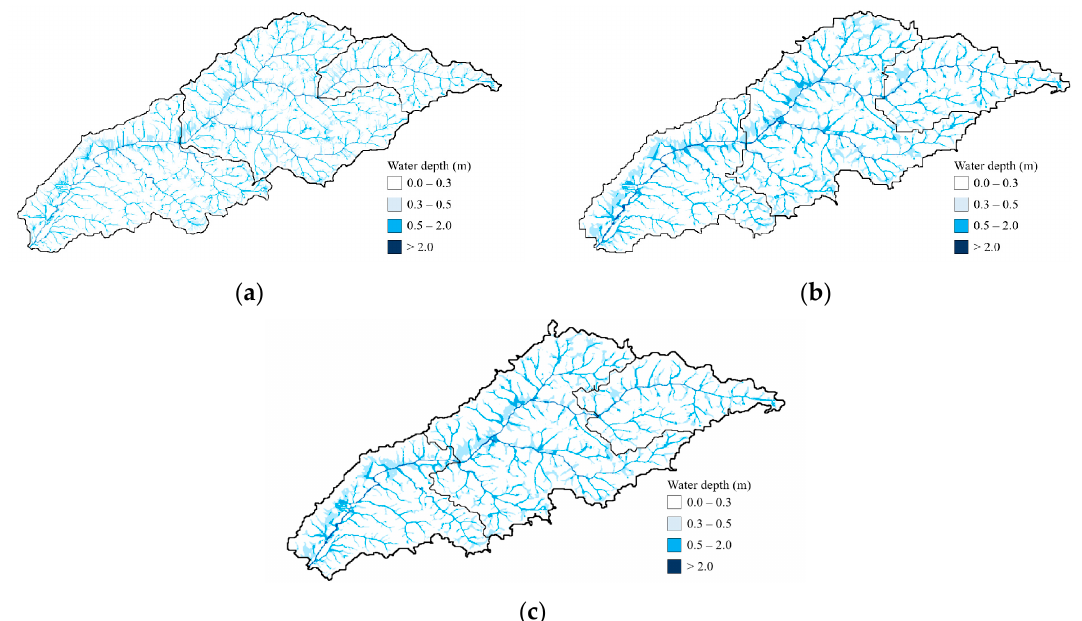
Figure 7. Comparison of water-depth distribution using different flow-direction methods: ( a ) D8 method; ( b ) MD4 method; ( c ) MD8 method.